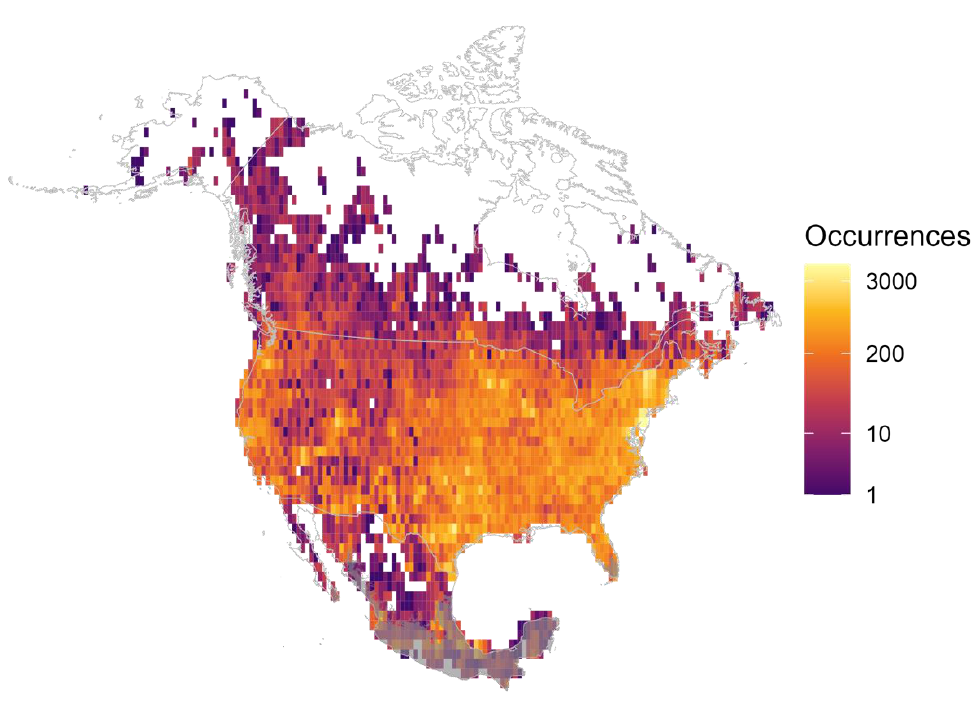
Figure 8. Odonata sampling effort in the Nearctic